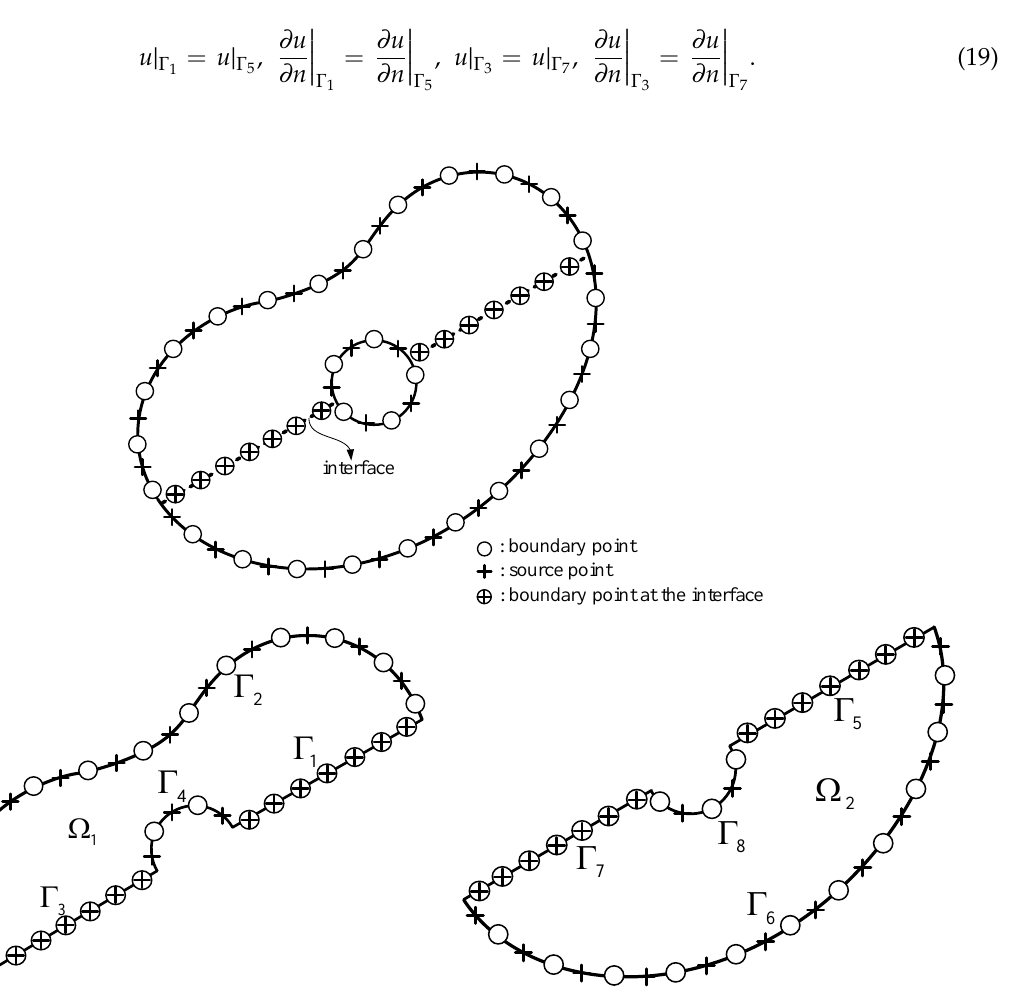
Figure 2. Diagram of the domain decomposition method (DDM) in a doubly connected region.